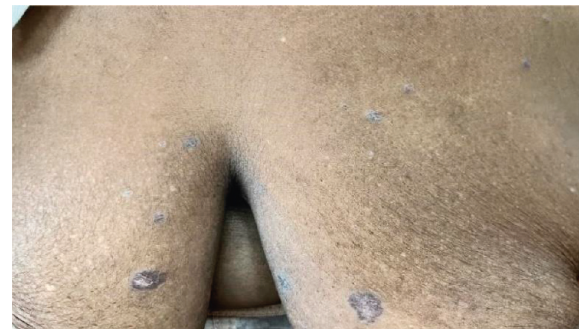
Figure 2: Multiple annular, hypertrophic, violaceous, well-de- marcated papules and plaques on the chest.